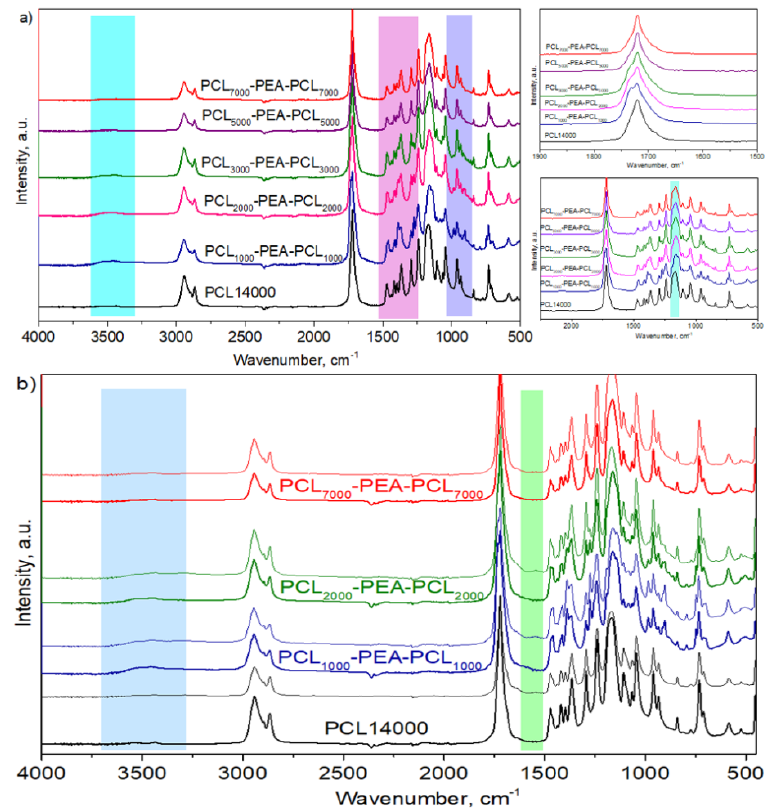
Figure 9. FTIR analysis of ( a ) control/blank polymer samples and ( b ) representative spectra of PCL homopolymer and PCL-b-PEA-b-PCL copolymers after 21 days of degradation in the presence of Pseudomonas lipase PAO1